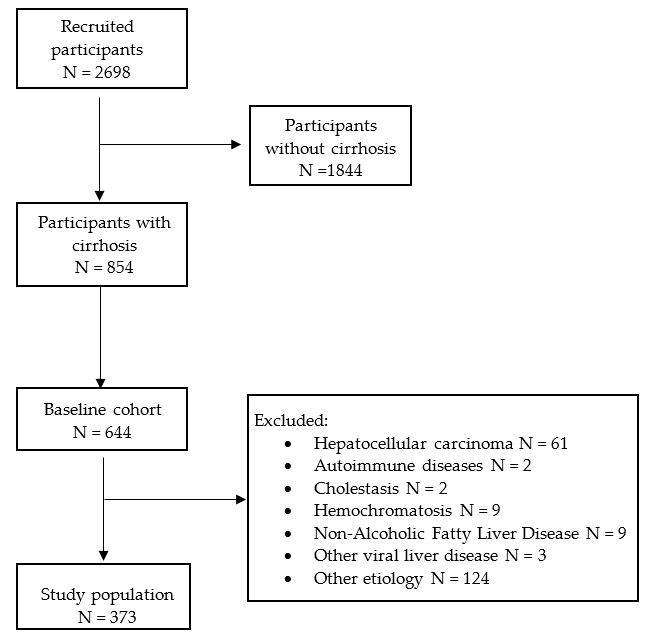
Figure 1. The flow chart of the study.